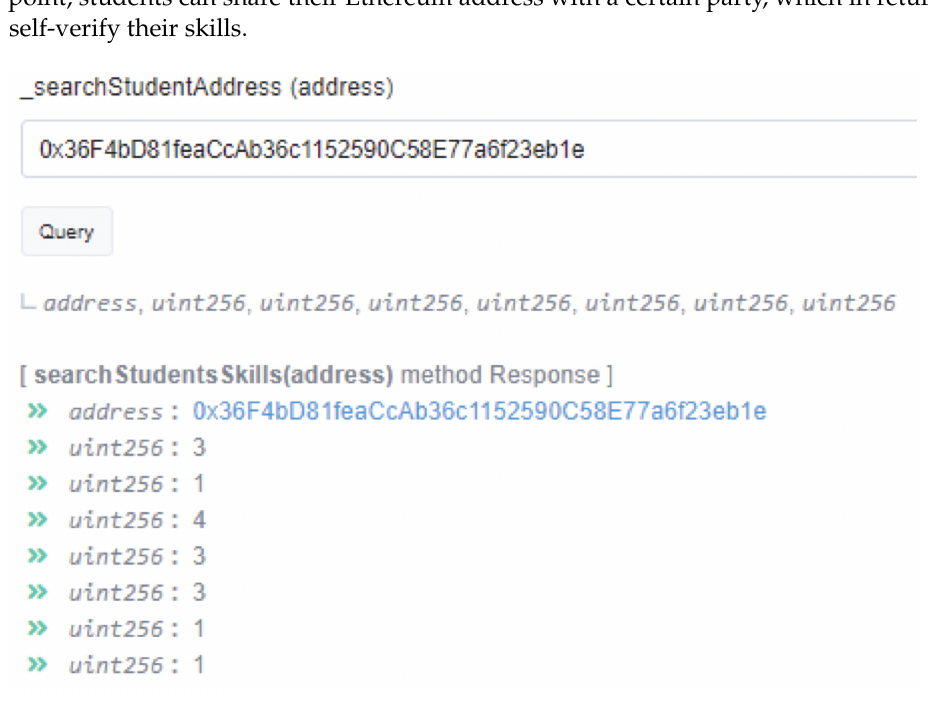
Figure 4. Real-time observed skill values for the specific